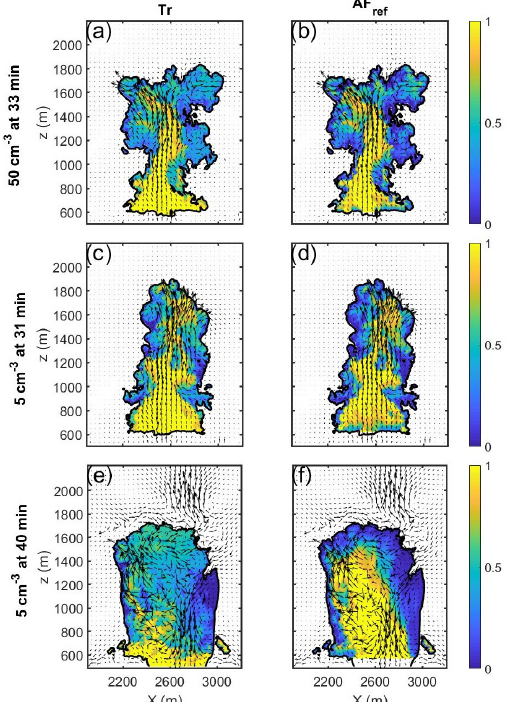
Figure A3. Comparison of AF ref and Tr for low N a . Cross sec- tions of AF ref and Tr for lower N a simulations. (a) Tr for 50cm − 3 at 33min. (b) Same as (a) for AF ref . (c) Tr for 5cm − 3 at 31min prior to intense sedimentation. (b) Same as (c) for AF ref . (e) Tr for 5cm − 3 at 40min during intense sedimentation. (f) Same as (e) for AF ref